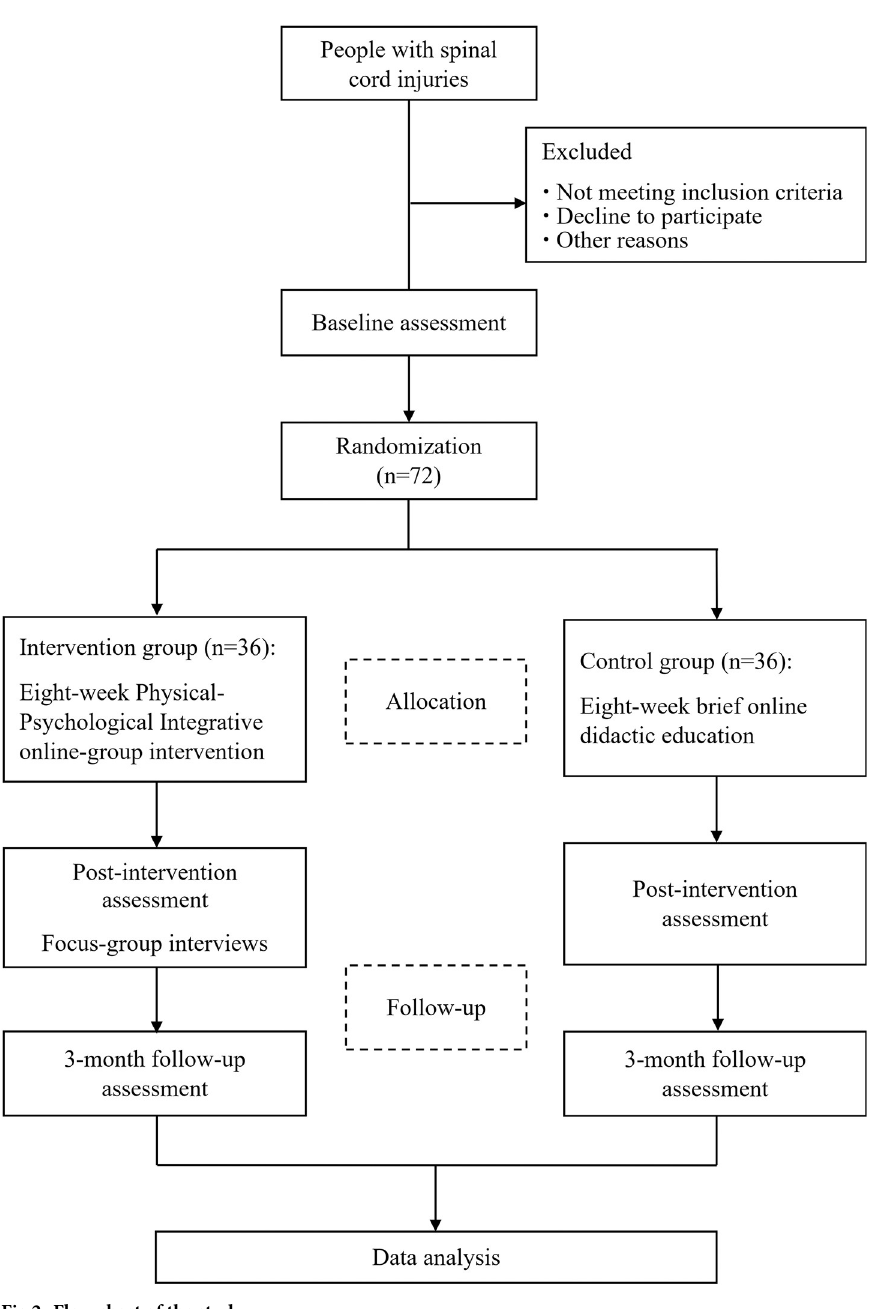
Fig 2. Flow chart of the